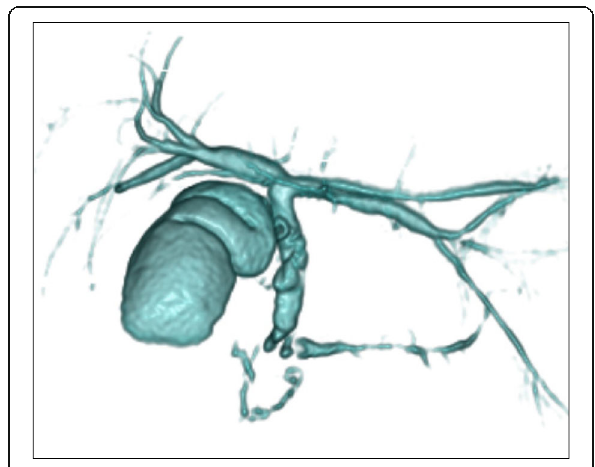
Fig. 2 Findings of magnetic resonance cholangiopancreatography. The annular pancreas duct around the second portion of the duodenum and filling defect of the main pancreatic duct in the pancreas head, shown by magnetic resonance cholangiopancreatography